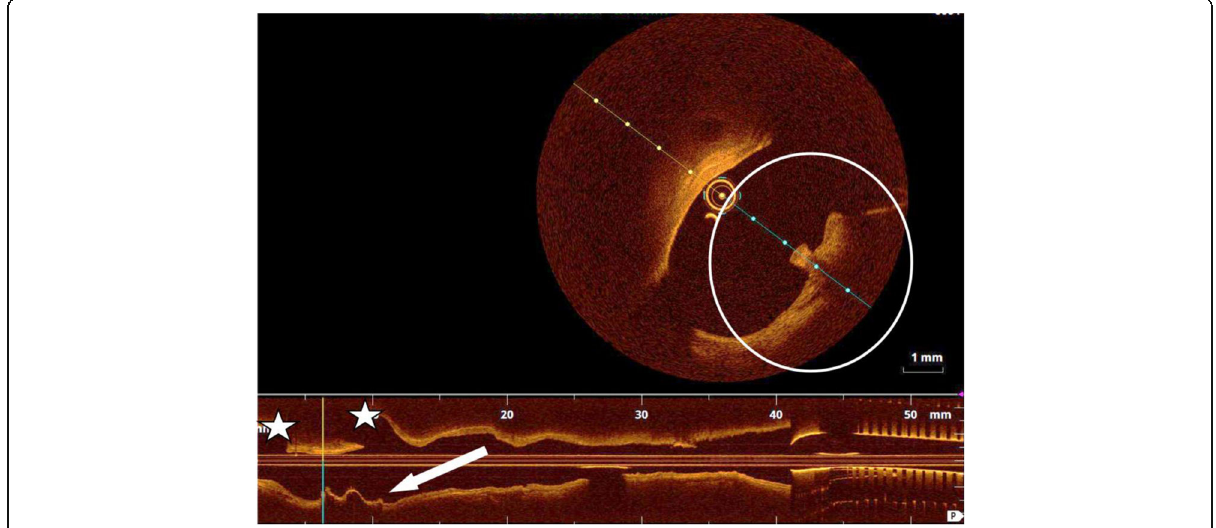
Fig. 4 OCT multiplanar view of the arterial lumen showing the correct placement of the device (white circle and white arrow). The white stars identify the origin of two lobar branches